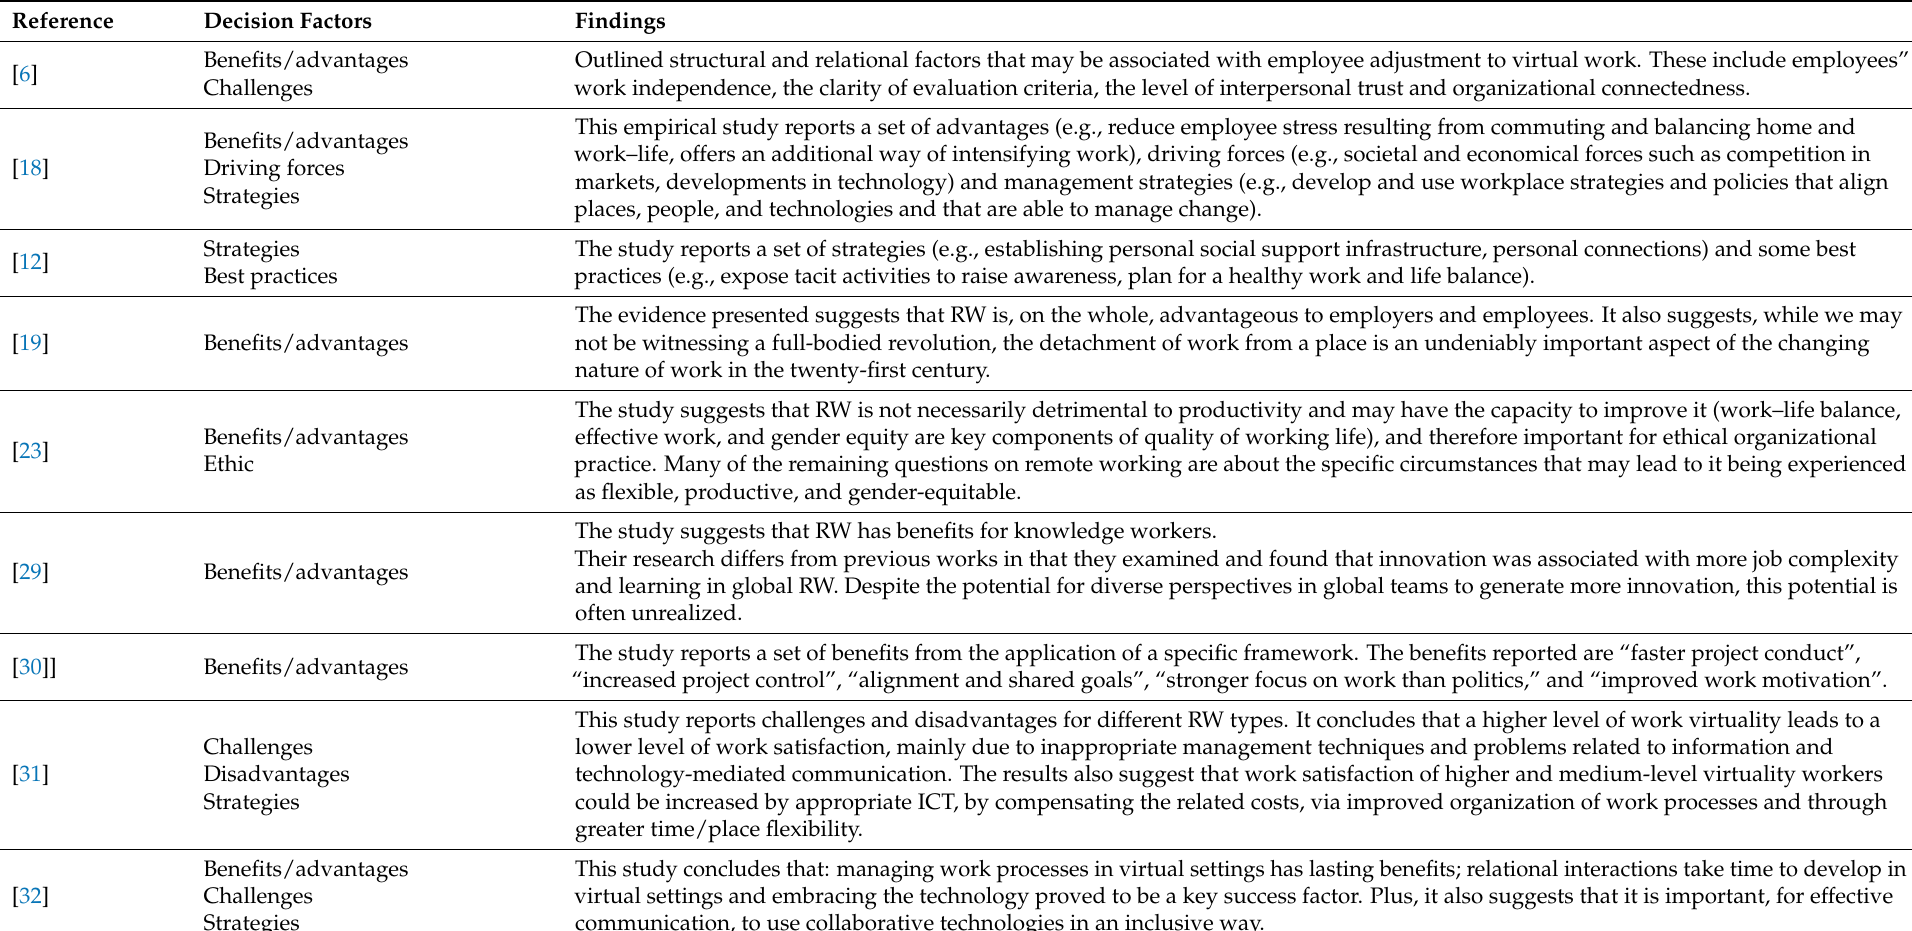
Table 1. Report on the findings in the